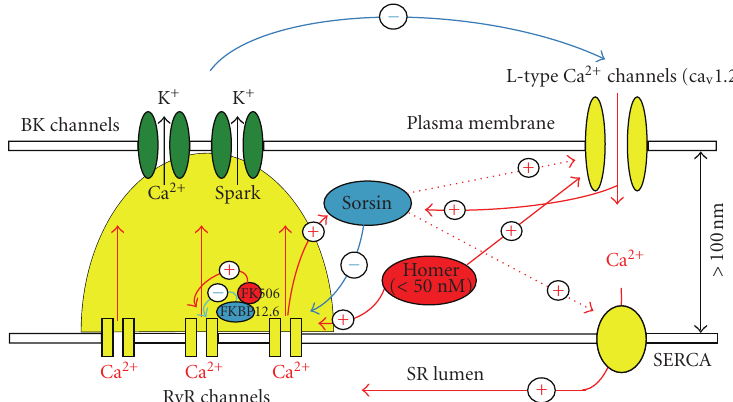
Figure 4: Putative role of sorcin, homer1, and calstabins in calcium spark regulation in smooth muscle . Sorcin (soluble resistance-related Ca 2+ binding protein) is a negative regulator of calcium sparks in SMCs. It is activated by increases in cytosolic [Ca 2+ ] (EC50 = 1.5 μ M). Stimulatory e ff ects on Ca v 1.2 channels and SERCA have also been reported. Calstabin2 (FKBP12.6) associates with RyR2 and stabilizes RyR2 channels in their closed state. FK506, an immunodepressant drug, binds to calstabin2 and can cause dissociation of calstabin2-RyR2 complex and therefore stimulation of calcium sparks in some smooth muscle tissues. Sca ff old protein Homer1 (Ves1) has been shown to stimulate both RyR2 (at doses < 50 nM) and Ca v 1.2 channels in nonarterial smooth muscle. Based on these findings, Homer1 can be expected to be a positive regulator of local calcium release calcium in this type of smooth muscle, which, however, has not been demonstrated so far. With respect to arterial smooth muscle, it is likely that calstabin2 and Homer1 play no role or only a minor role in calcium spark generation. This speculation is based on our findings that cytosolic [Ca 2+ ] itself contributes minimally to the acute triggering of physiologically relevant proportion of calcium sparks. Instead the most e ffi cacious calcium spark trigger appears to be the luminal SR Ca 2+ , which is slowly loaded via Ca 2+ influx through Ca v 1.2 channels. Arrows indicate positive (red, +) and negative (blue, − ) regulation of corresponding